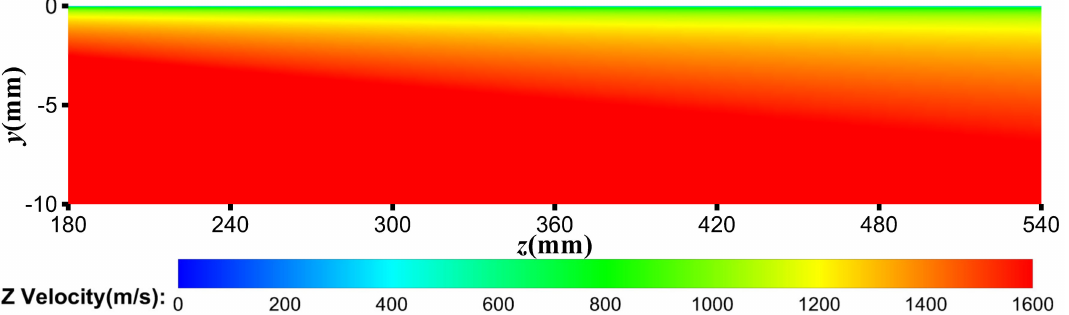
Figure 11. Velocity distribution of high-temperature